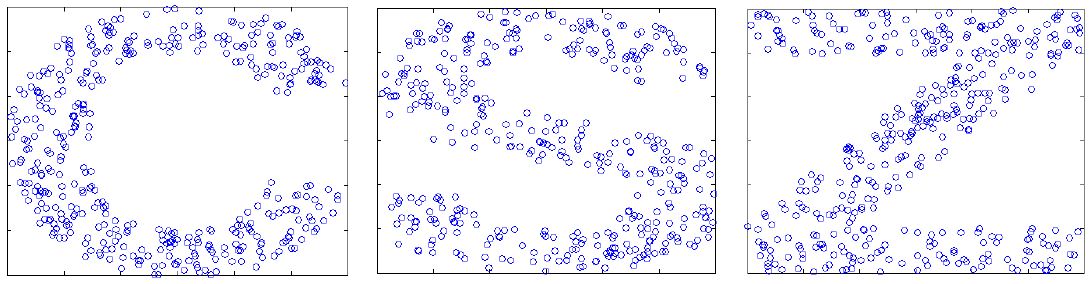
Figure 9. The random distribution of nodes.